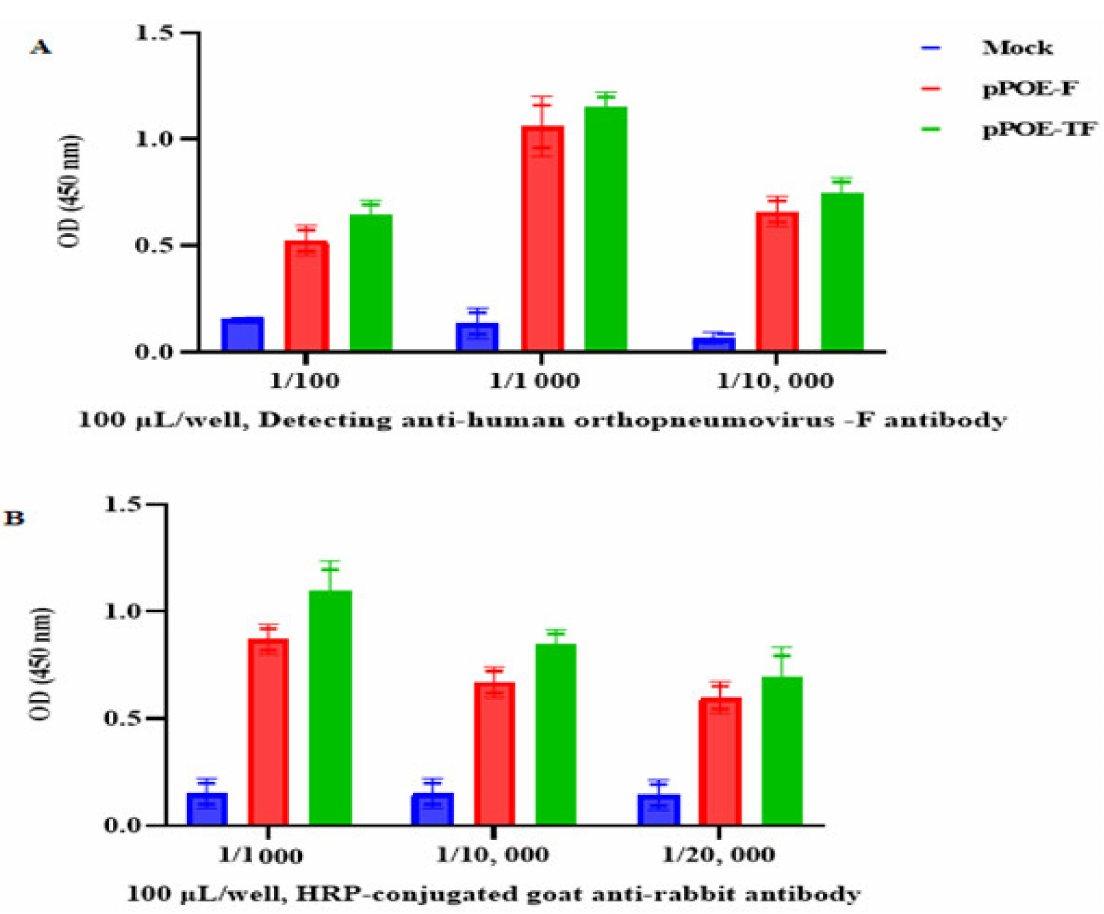
Figure 6. ( A ) Graph showing optimal dilution of detecting anti-human orthopneumovirus F antibody for each MPA; various dilutions for detecting anti-human orthopneumovirus F antibody were adsorbed in microtiter wells and tested for their ability to bind 50 ng/mL of recombinant human orthopneumovirus F protein, and detected by ( B ) various dilutions of HRP-conjugated goat anti- rabbit IgG-Fc secondary antibody in 1% blocking buffer. OD values are the mean of two independent experiments and bars represent means ± SD measured in each MPA. Differences between rats immunized with pPOE-F and pPOE-TF were statistically